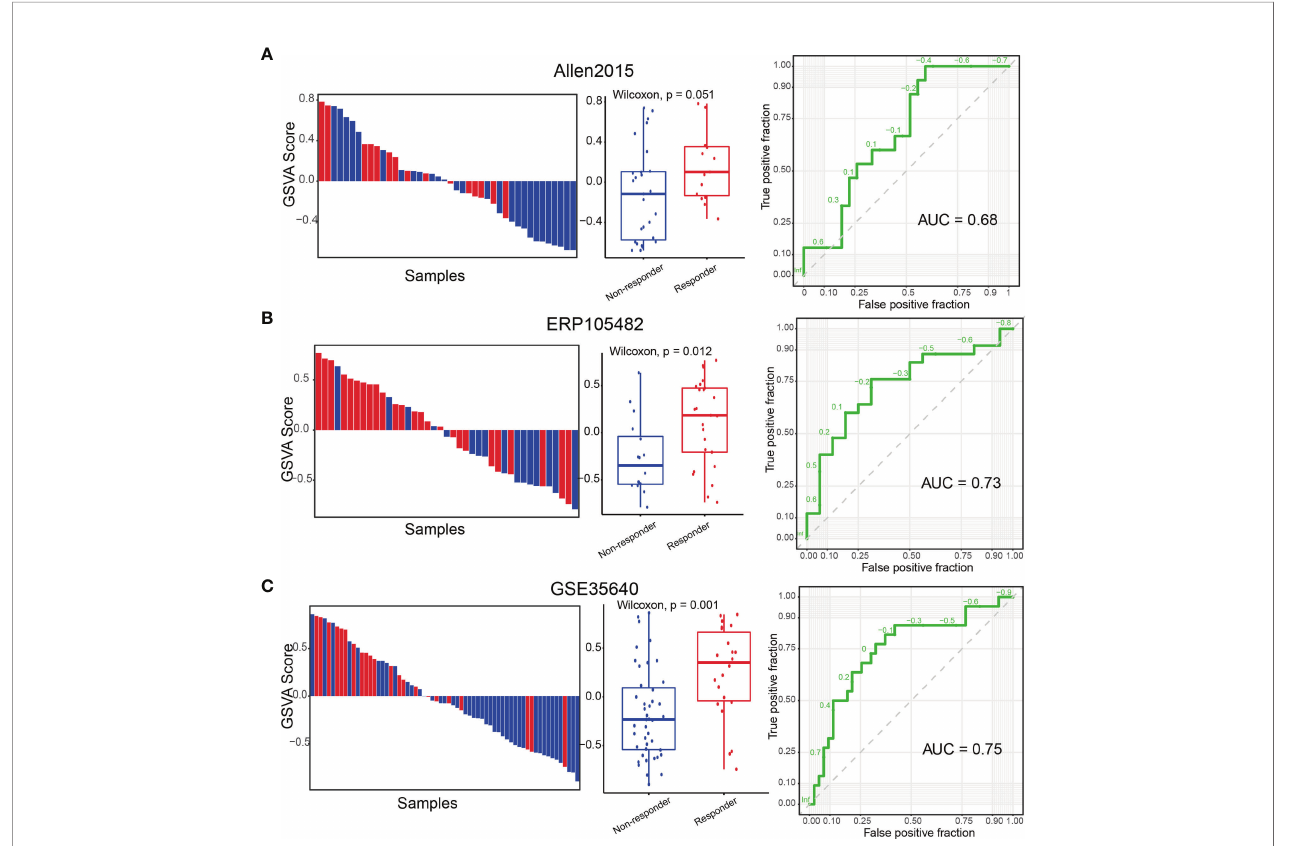
FIGURE 6 | The TRS score predicts response to immunotherapy in melanoma. (A) (Left panel) Waterfall plot of the TRS scores depicting immunotherapy response of melanoma patients from the Allen2015 cohort. (Middle panel) Boxplots showing differences of the TRS scores between responders and non-responders. (Right panel) ROC curves for the performance of TRS in predicting response to immunotherapy. (B, C) Same as (A) for the ERP105482 cohort (B) and the GSE35640 cohort (C)